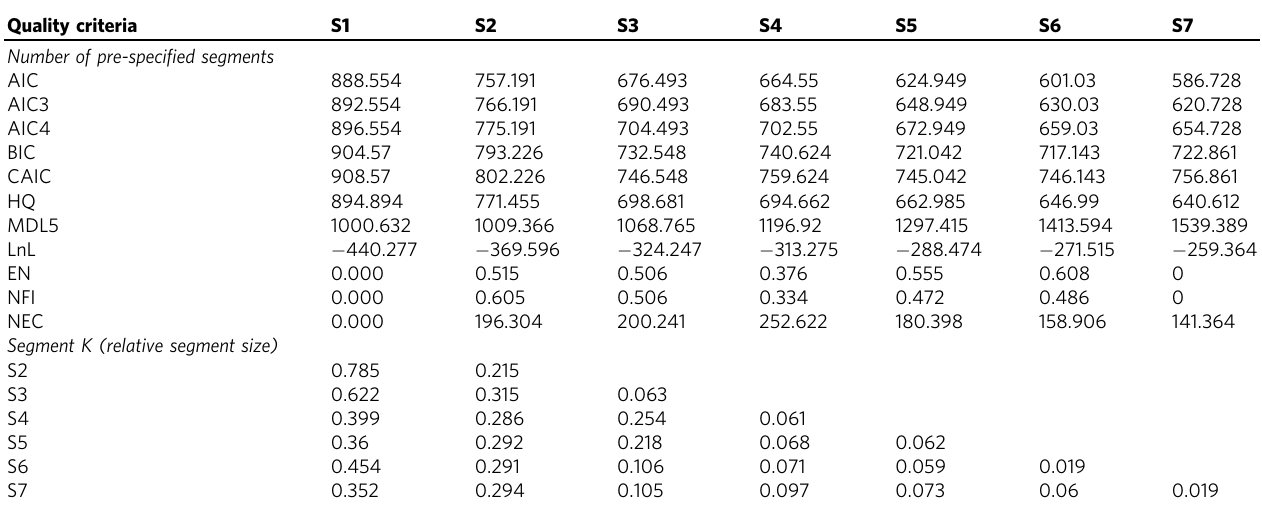
Table 6 FIMIX-PLS calculations for segmentation. Quality criteria